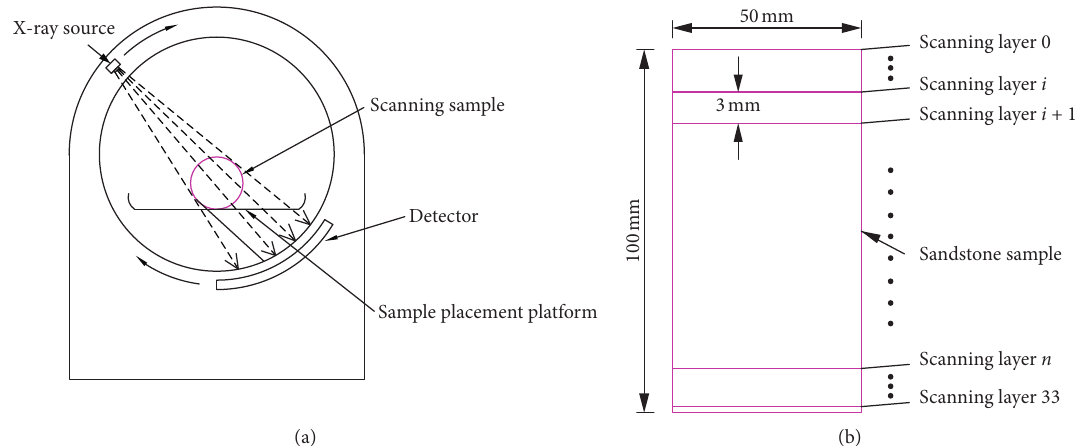
Figure 3: CT scanning schematic diagram of the rock sample. (a) The scanning principle of Philips Brilliance 16 spiral CT. (b) Layered scanning schematic diagram of the rock sample.